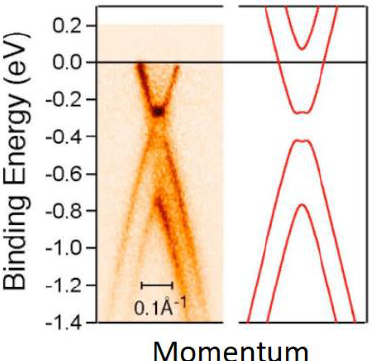
Figure 3. Band structure of BLG on SiC(0001) from ARPES and theoretical (solid lines). Reprinted with permission from Reference [34]. Copyright (2006) American Association for the Advancement of Science.